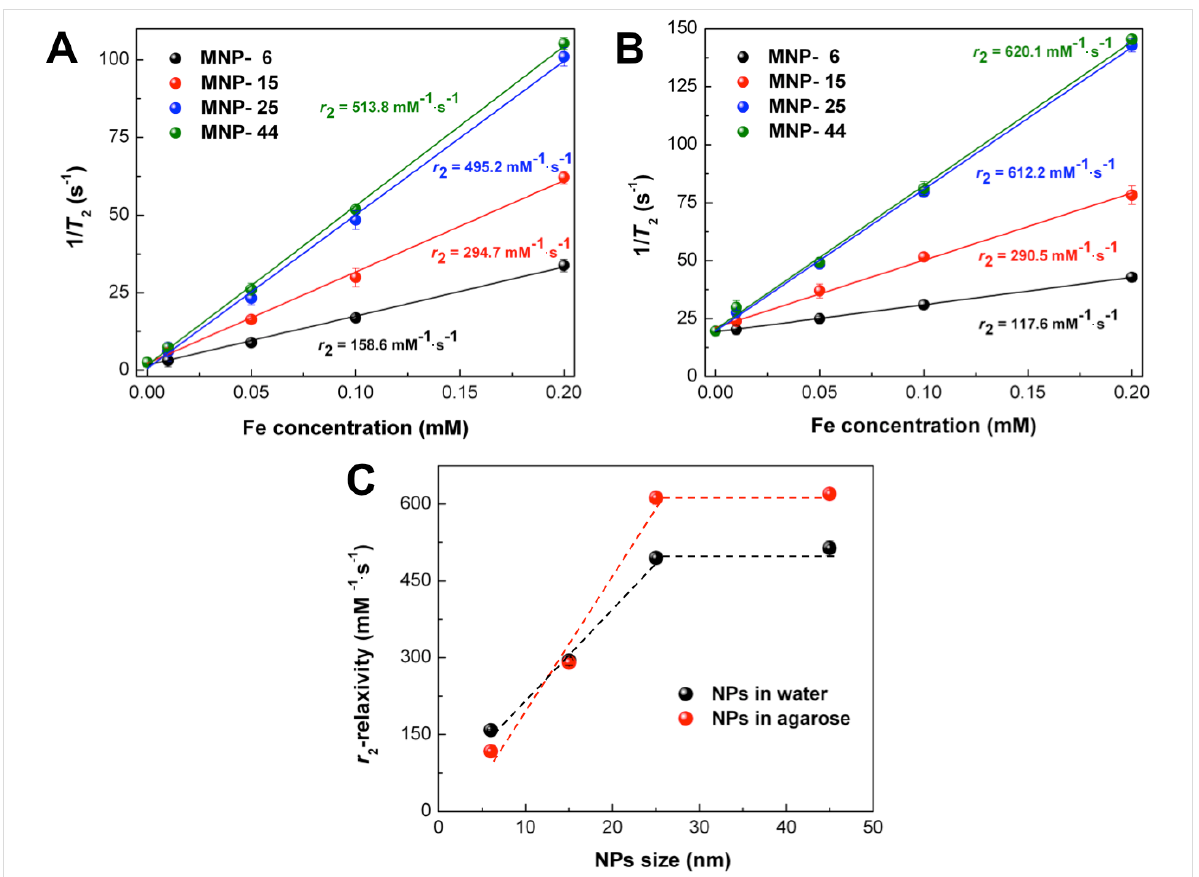
Figure 5: Inverse of the MRI proton T 2 -relaxation time as a function of iron concentration for MNP-6, MNP-15, MNP-25 and MNP-44 in water (A) and 2% agarose (B). The r 2 values are determined by the slopes of the linear fits. C) r 2 values as a function of NP size in water and agarose. The SDs are smaller than the symbol